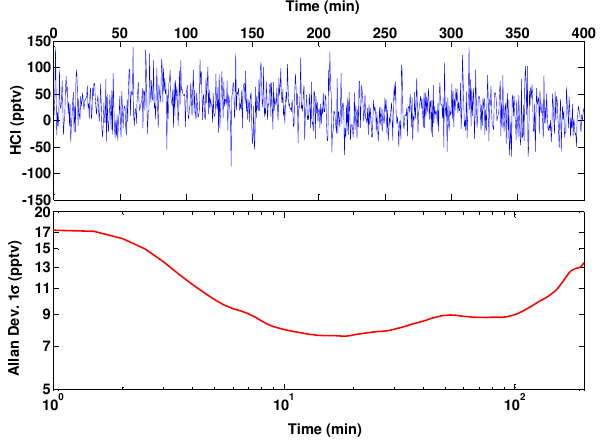
Fig. 7. (Top) Sample ring-down data when the optical cavity was purged with ultra-zero air. (Bottom) Modified Allan Deviation of the ring-down data (red solid line) as compared to the idealized data without drift, i.e. time − 1 / 2 dependence (blue line). The average rate at which ring downs are acquired is ∼ 20 Hz, however, it is not constant, as the computer simply triggers whenever a resonance is detected.